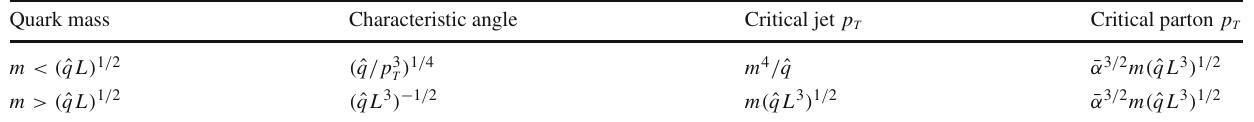
place at the critical jet p T scale given in the third column. For a single parton, massless and massive quark quenching starts deviating at the characteristic parton p T , given in Eq. (24)